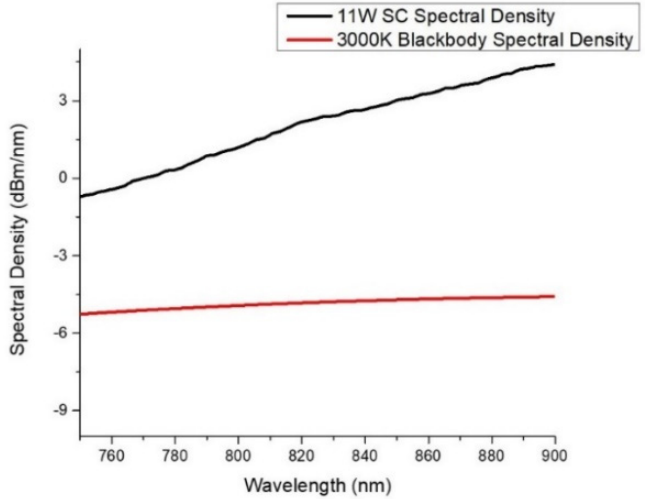
Figure 3. Comparison of spectral density coupled into 1-mm 2 area fiber between 3000-K black body emitter and SC laser used in this study.